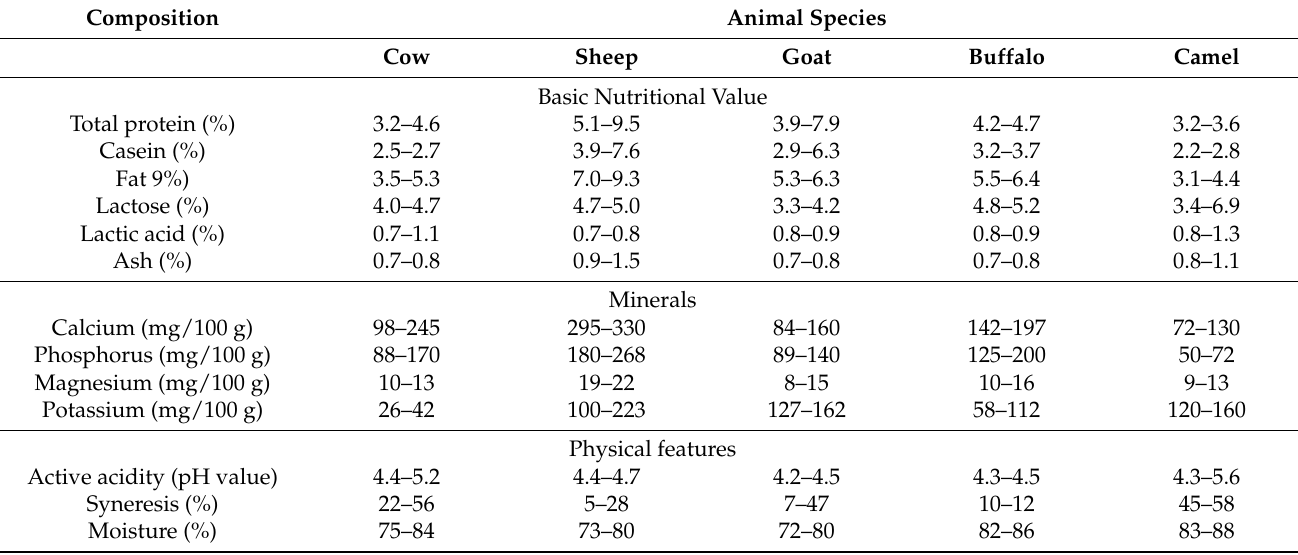
Table 2. Comparison of the content of basic ingredients and physical properties of natural yoghurt made from milk obtained from various animal species